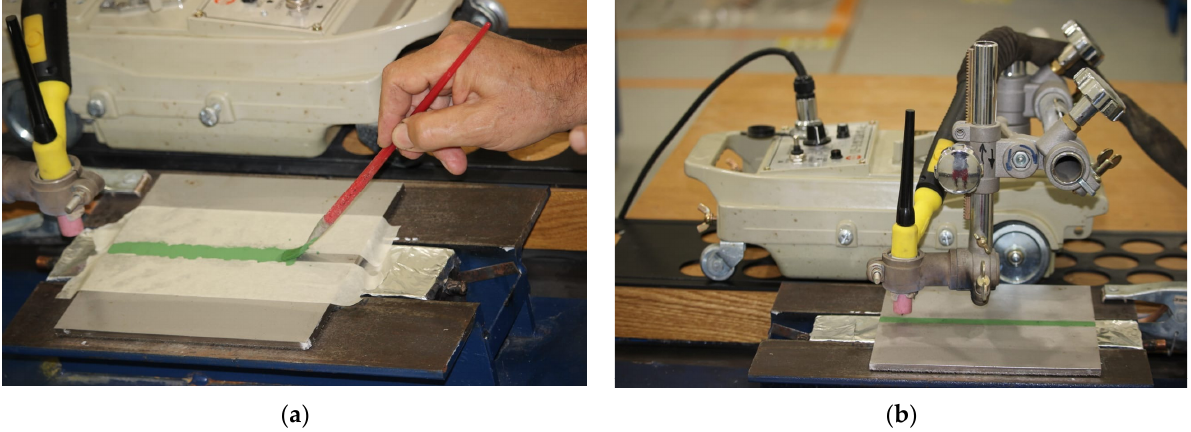
Figure 1. The deposition of flux on the workpiece ( a ), motorized carriage ( b ). Table 2. Welding parameters.